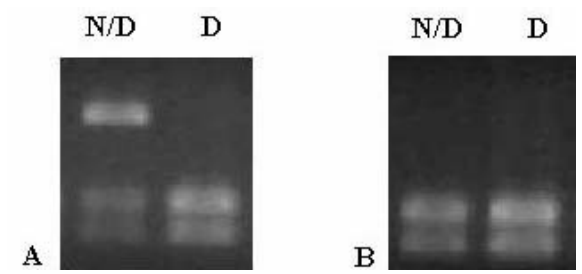
Figure 2 - The H19DMR methylation pattern as determined by HhaI RFLP analysis (Lane N/D = HpaII undigested DNA; Lane D = HpaII di - gestedDNA):A)Monoallelicmethylationdemonstratedbytheabsenceof the larger HhaI allele (upper band) in the HpaII digested DNA; B) Non-informativecasehomozygousforthesmaller HhaI allele(seetextfor details).